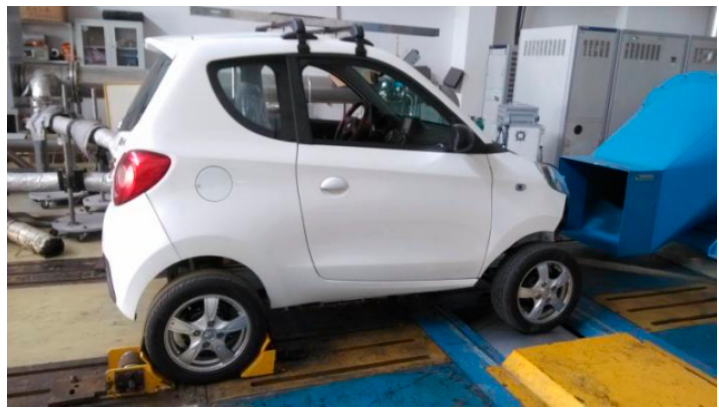
Figure 11. Road simulation test.